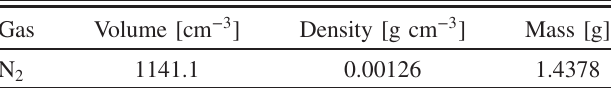
TABLE X. Characteristics of the BLM active gas region as modeled in the FLUKA geometry.